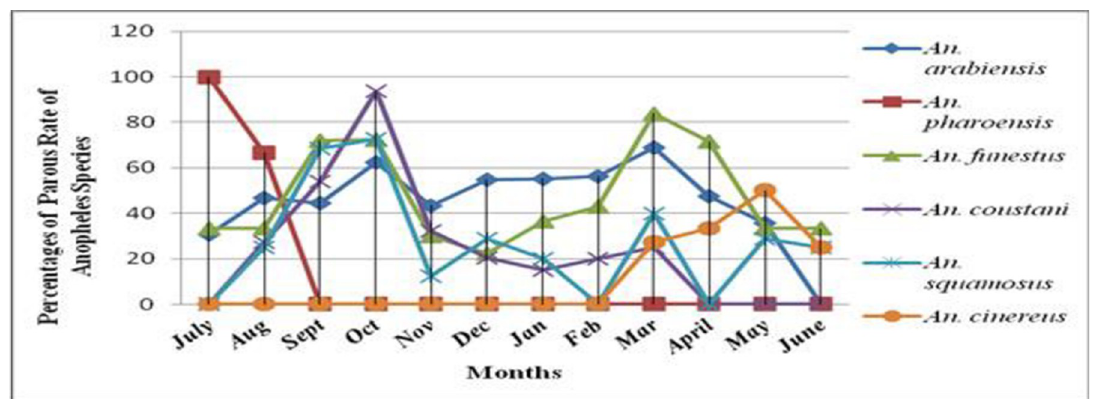
Fig 1. Mean monthly parous rates of Anopheles mosquito in Bure district, Ethiopia (July 2015—June 2016).